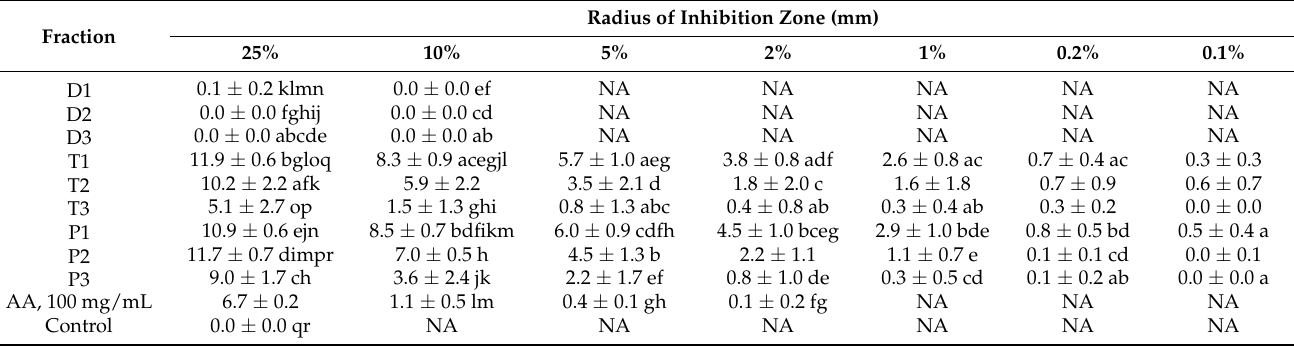
Table 3. Inhibition zones of the pyrolysis fractions against Listeria monocytogenes .